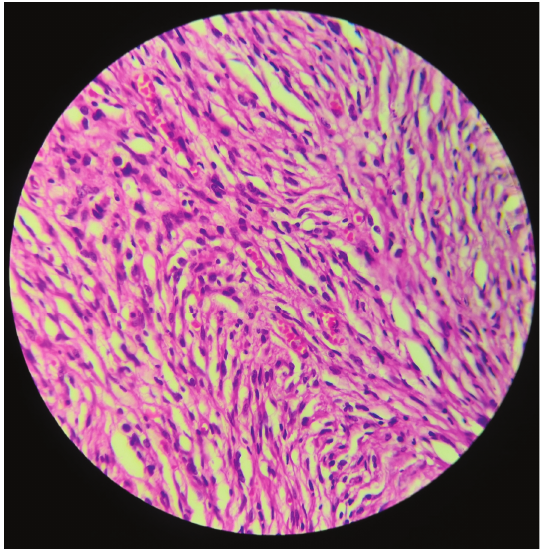
Figure 2 : The neoplastic cells are arranged in fascicles with a storiform pattern. The spindle stromal cells have a fibroblast-like feature. Round to oval shape nuclei, primitive features, and conspicuous mitotic figures are noted in some of the neuroepithelial cells (H&E staining, ×